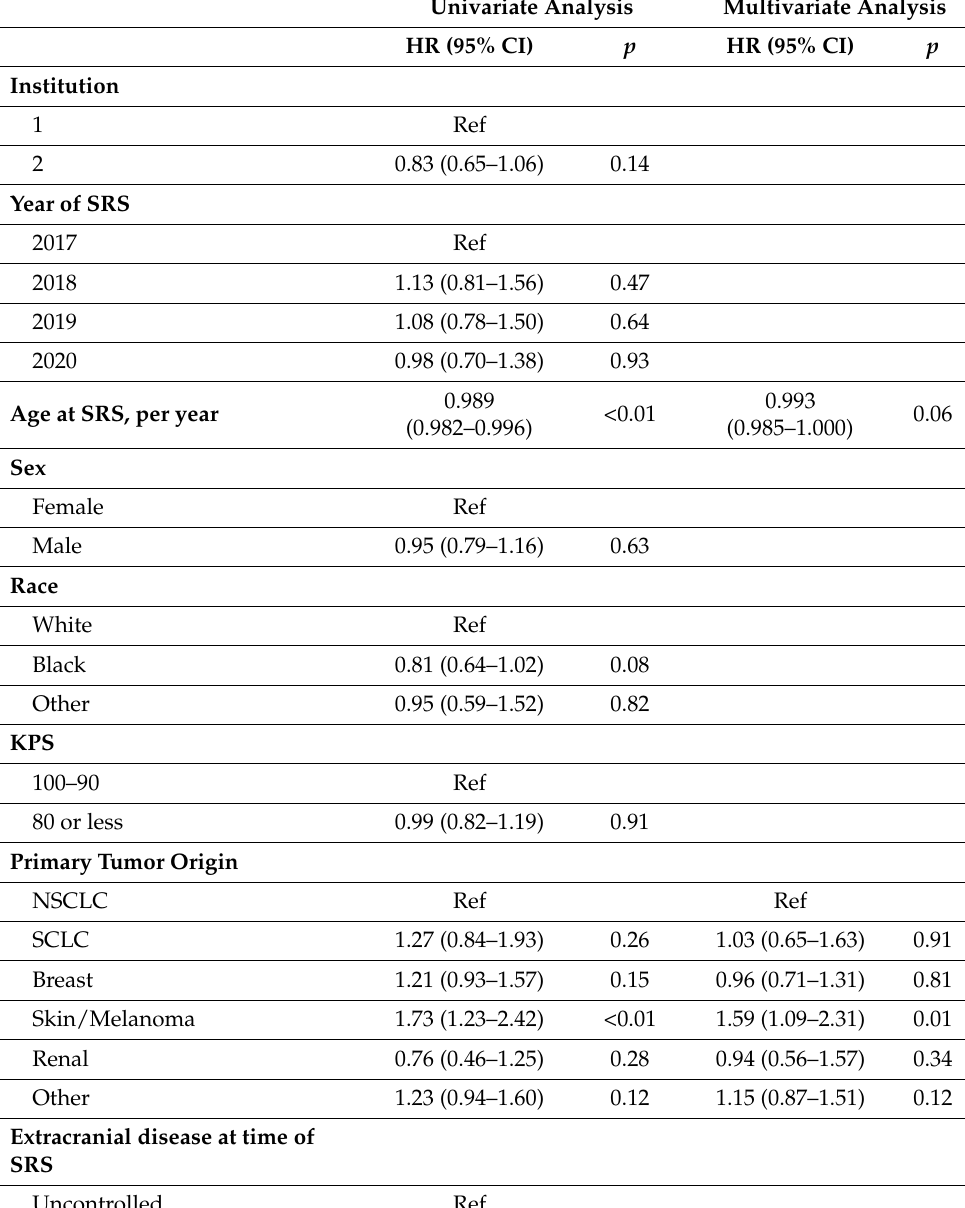
Table 5. Univariable and multivariable analyses are provided for intracranial progression across all patients. Abbreviations: Interquartile range, IQR; stereotactic radiosurgery, SRS; non-small cell lung cancer, NSCLC; small cell lung cancer,